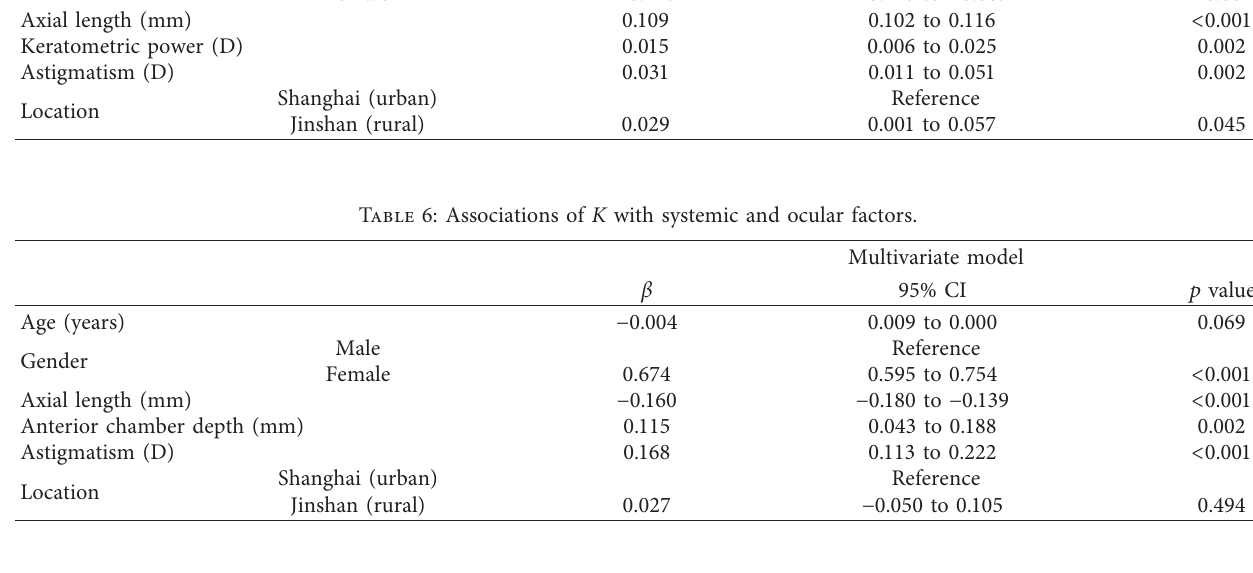
Table 7: Associations of CA with systemic and ocular